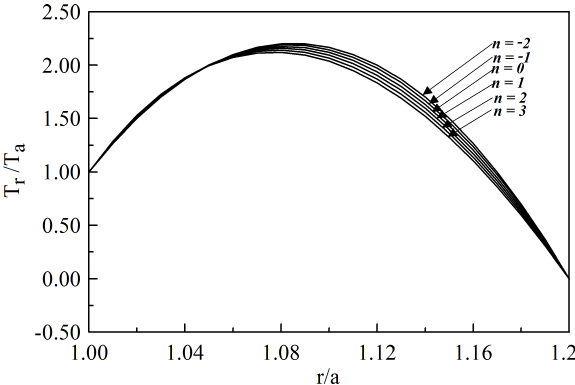
Figure 38: Radially distributed radial stress